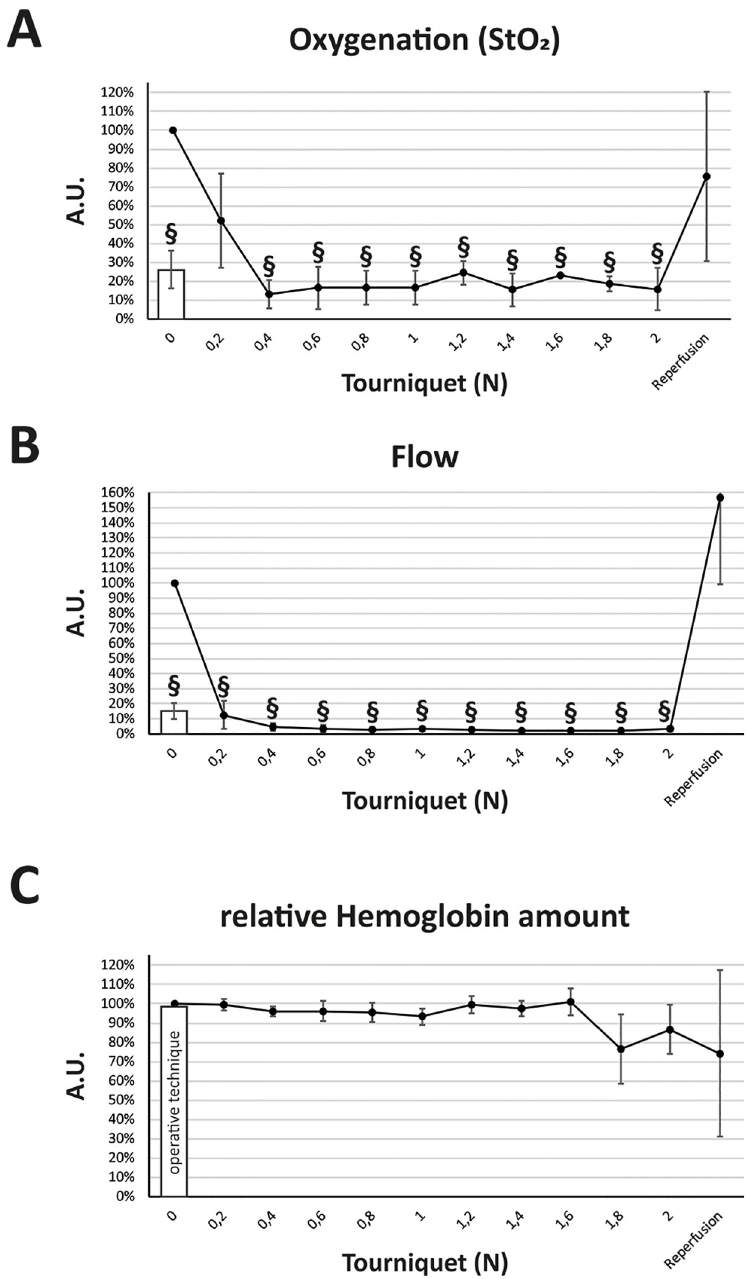
Fig 2. Microcirculatory measurement of oxygenation, flow and relative hemoglobin amount in the tourniquet and operative clamping model. (A) Using the O2C device, relative oxygenation of the murine hind limb was significantly reduced at a force of 0.4 N with no further reduction by increasing pressure. The operative clamping model (bar) showed a significant reduction but not as high as the low-pressure tourniquet. (B) Microvascular flow was significantly decreased at a force of 0.2 N and upwards compared to the control as well as in the operative technique (bar). (C) The relative hemoglobin amount was not significantly changed by either the operative clamping technique or increasing tourniquet pressure. Results are shown as means ± SEM. P-value: # < 0.05; § < 0.001; (two sample t-test), n = 4.